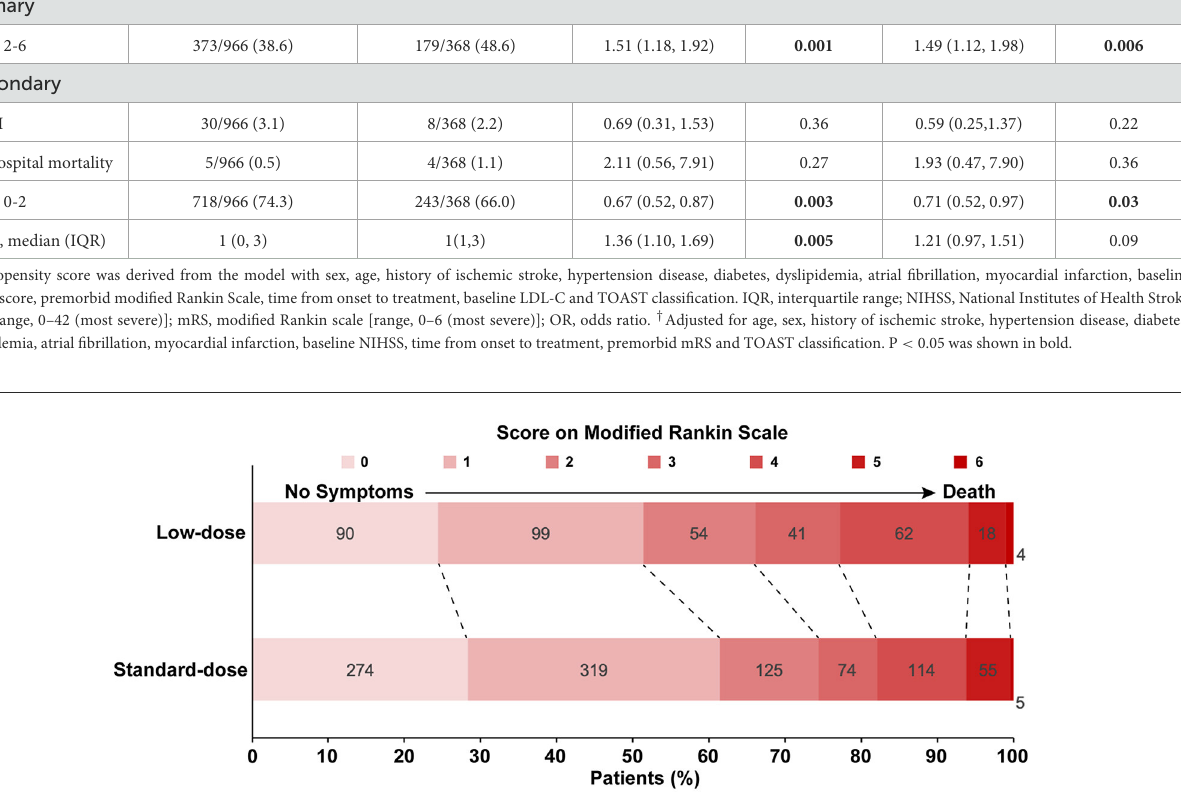
FIGURE2 Distribution of Modified Rankin Scale Scores on discharge by low-dose vs. standard-dose alteplase in propensity score matching dataset.